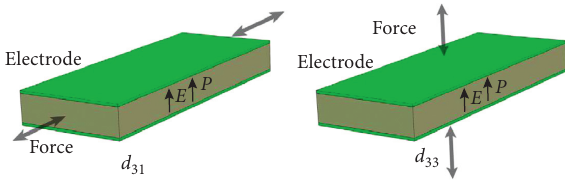
Figure 1: The d 31 and d 33 operation modes